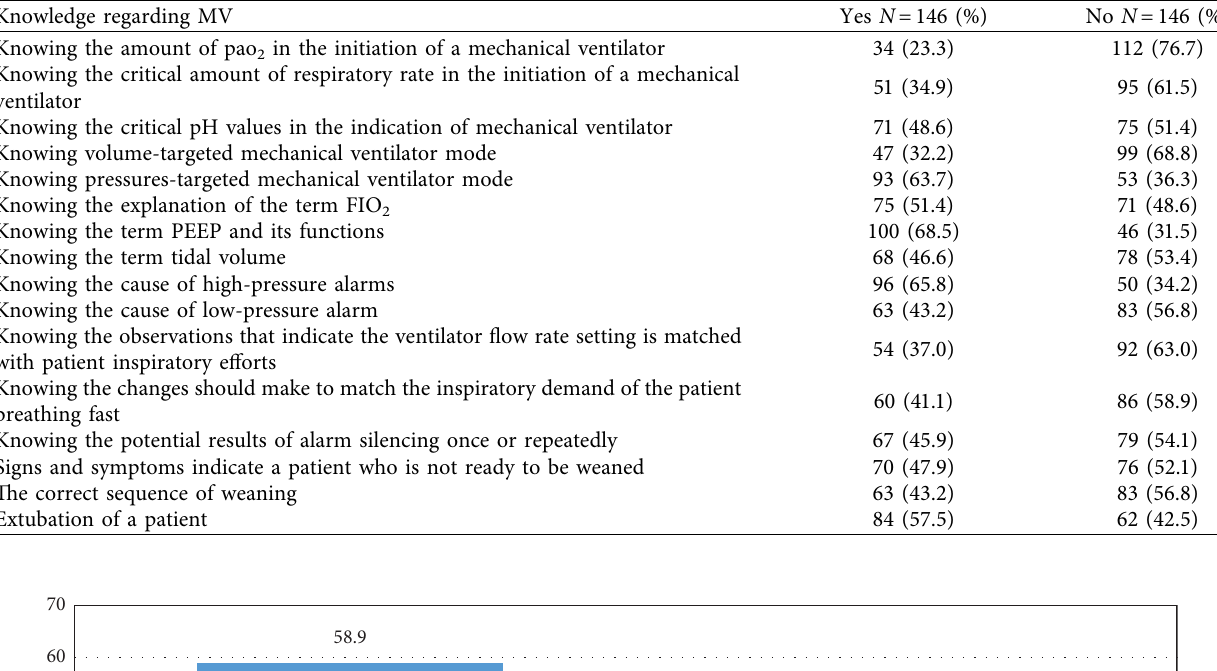
Table 2: Knowledge of nurses working in intensive care units regarding mechanical ventilators at the selected government hospitals in Addis Ababa, Ethiopia 2021 ( N � 146).